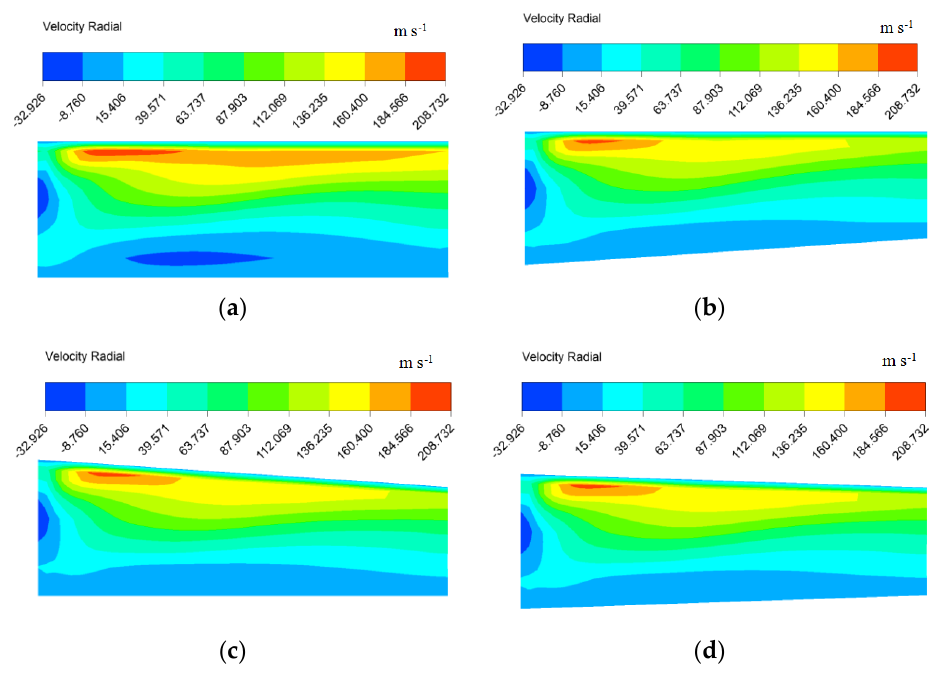
Figure 5. Radial velocity distribution on the meridional surface at 1.125 relative mass flow: ( a ) parallel; ( b ) convergence from shroud; ( c ) convergence from hub; ( d ) equal convergence from shroud and hub.